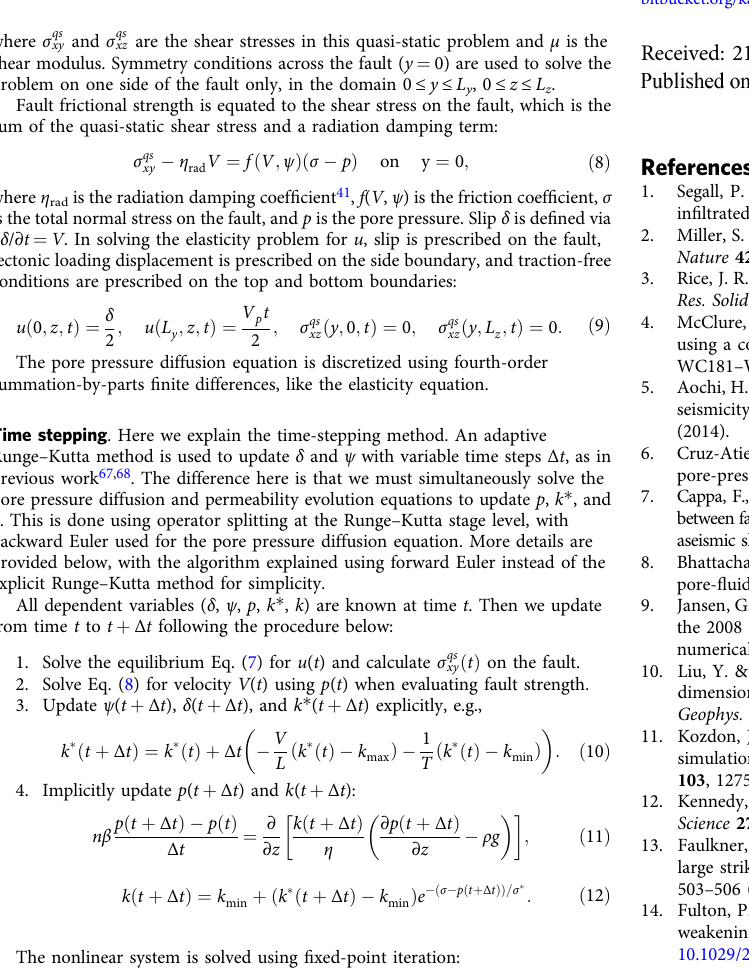
Fig. 6 Comparison of propagation rates of fl uid-driven aseismic slip and overpressure fronts in fault valving simulations with various T . Decreasing T leads to faster propagation rates. The T = 0.317 year model uses q 0 = 3.3 × 10 − 10 m s − 1 rather than 3 × 10 − 9 m s − 1 , as in the other